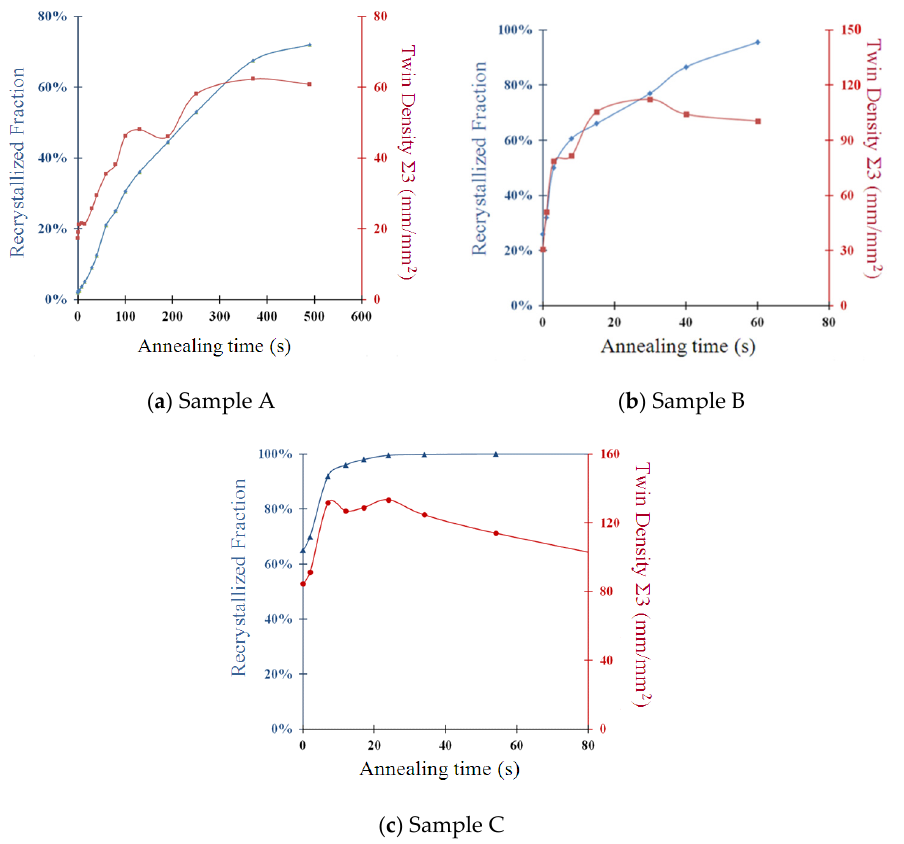
Figure 9. Recrystallized volume fraction and annealing twin density evolution during post-deformation annealing at 1020 °C in samples A, B and C.